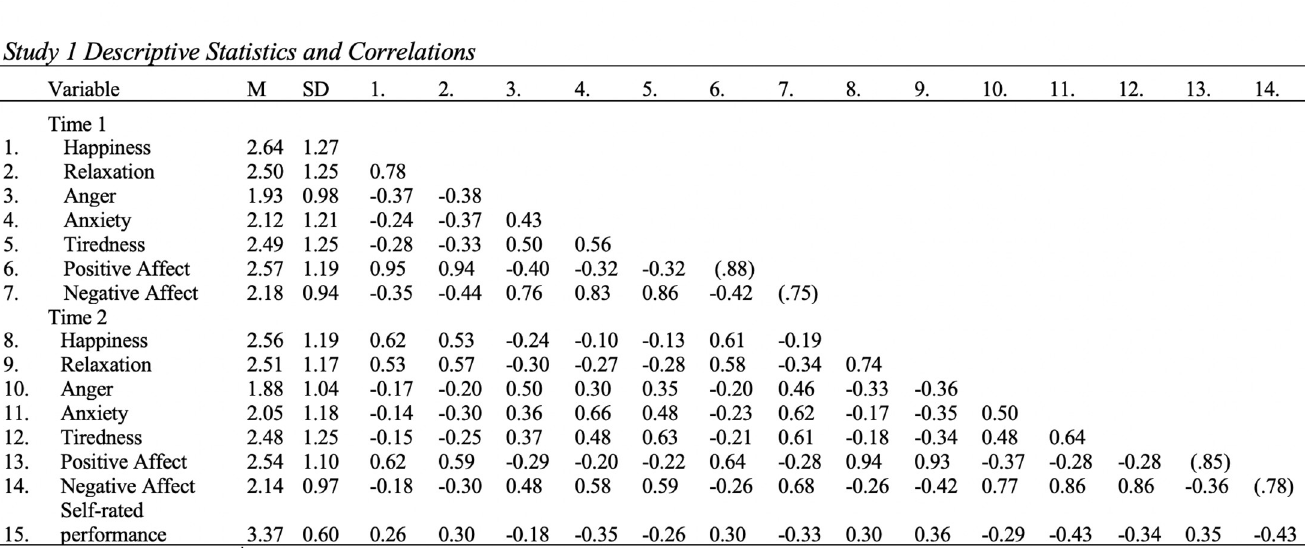
PLOS ONE | https://doi.org/10.1371/journal.pone.0235973 July 13,